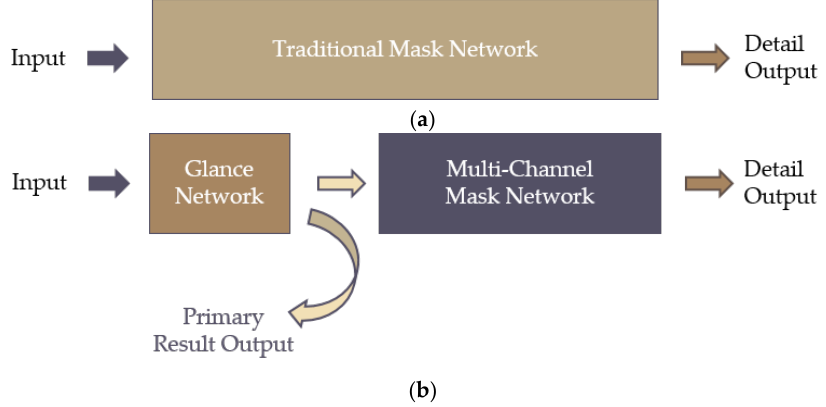
Figure 6. Structure difference between traditional mask network and the improved model. ( a ) Traditional mask network model, ( b ) Improved mask network model with glance network.